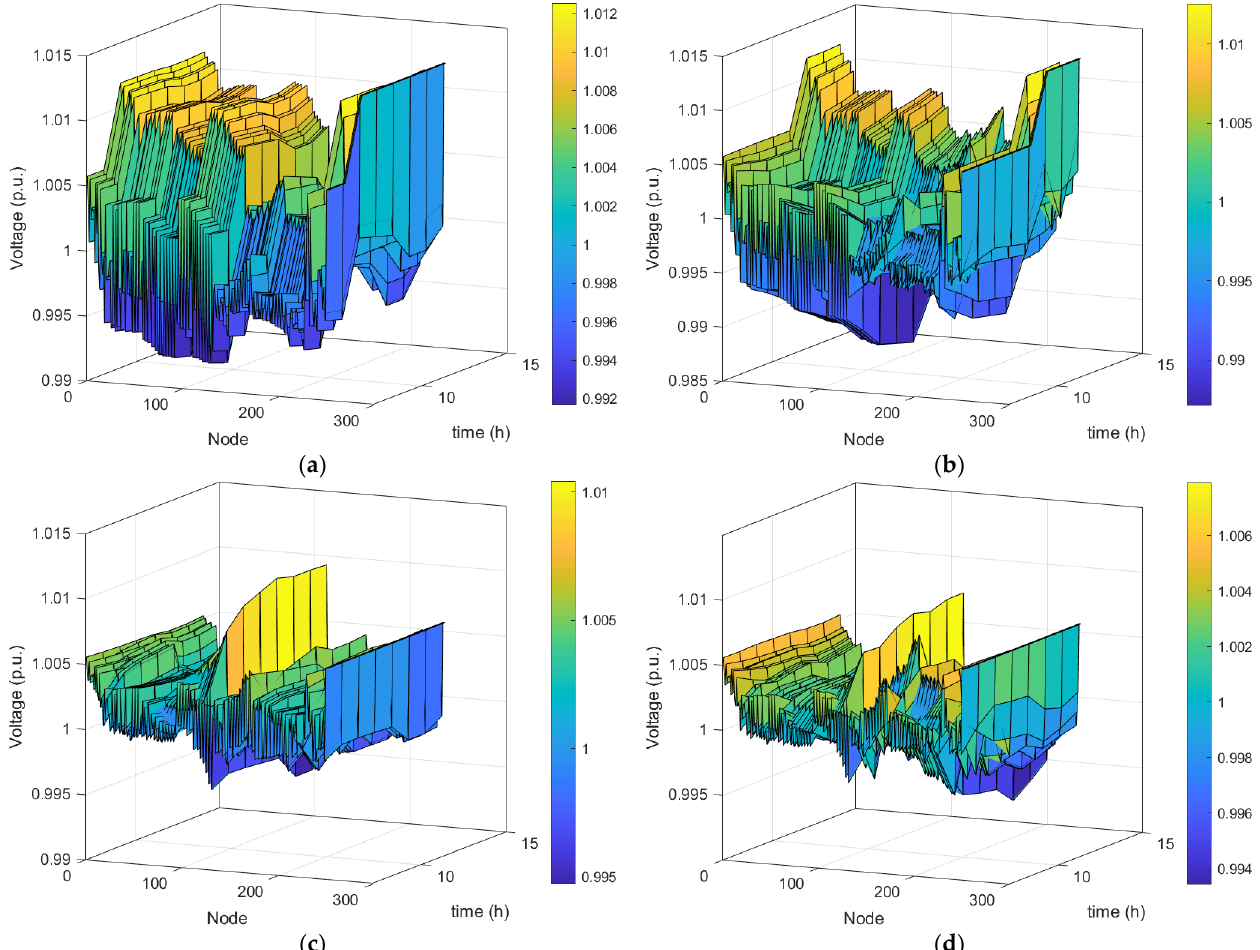
Figure 3. Hourly variations of the active power delivered from the PCC under the different cases.